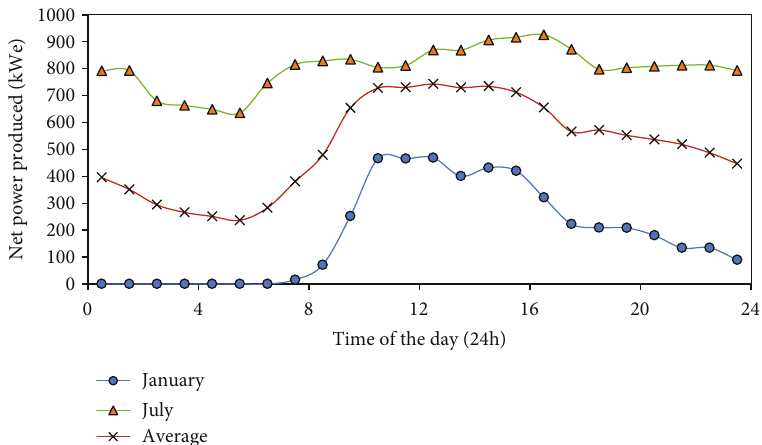
Figure 18: Typical monthly net power output pro fi le of